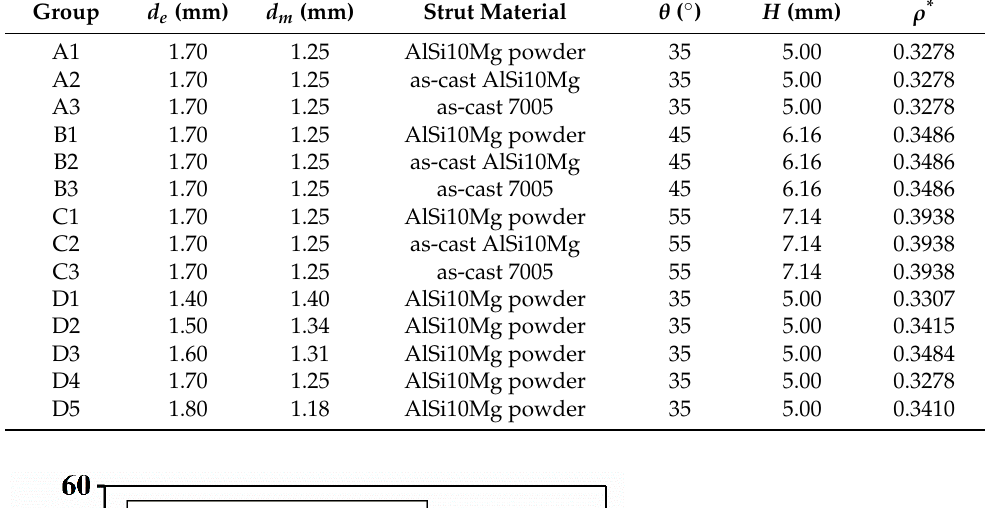
Table 1. Parameters of lattice structures.